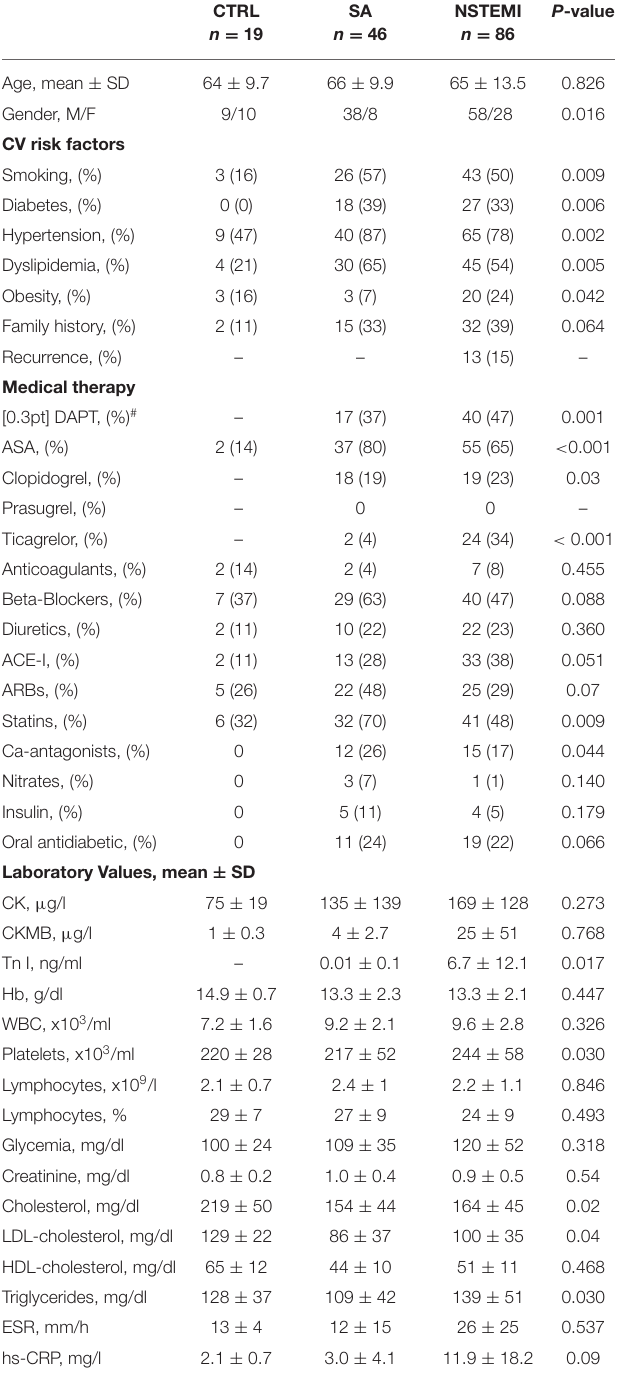
TABLE 1 | Baseline characteristics of the study